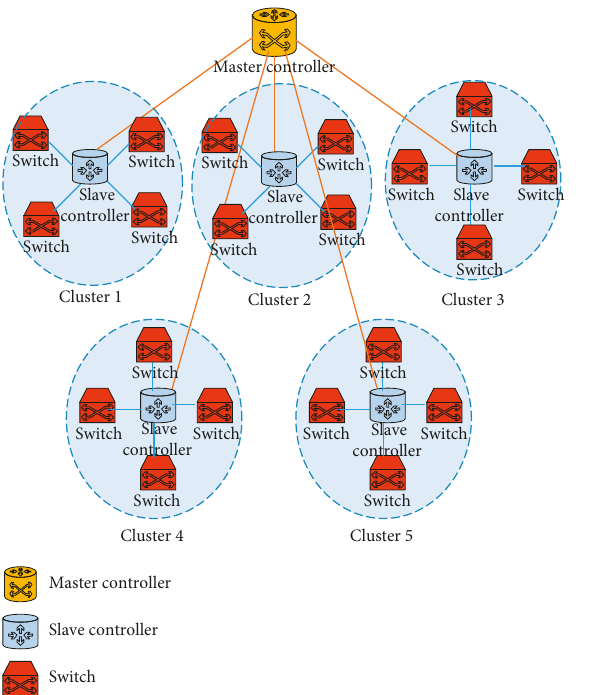
Figure 3: Five slave controllers connected to a master controller in a master-slave architecture.